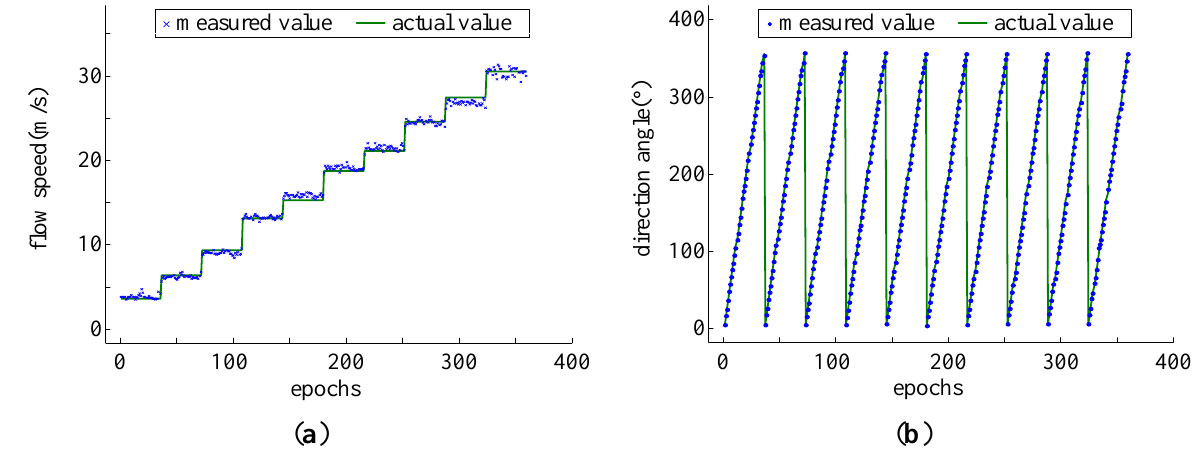
Figure 10. Measurement results, ( a ) for flow speeds and ( b ) direction